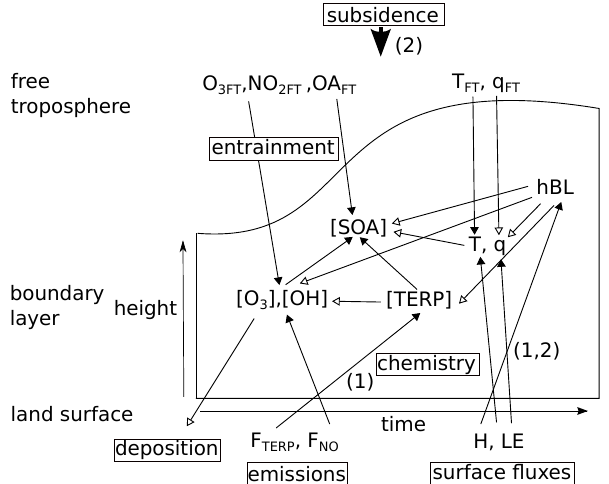
Fig. 1. Scheme of the interactions in and the boundaries of the sys- tem studied in this work. The numbers relate to the forcings of the system that are varied in the sensitivity analysis. Closed arrows in- dicate a positive relation, open arrows a negative relation and pro- cesses are indicated in the